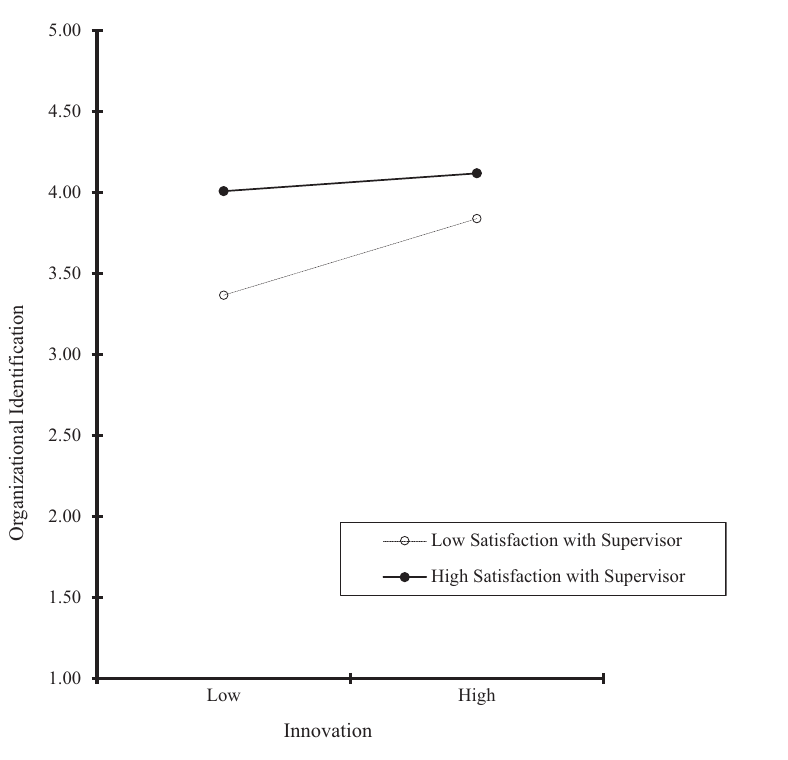
Figure 4. Interactive effects of satisfaction with supervisor on the relationship between innovation and organizational identi fi